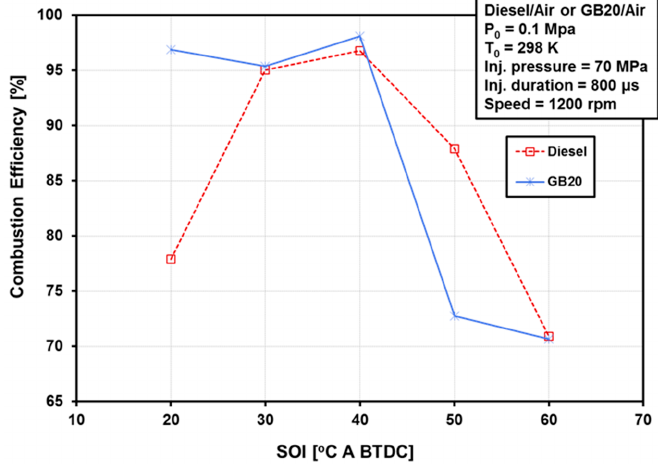
Figure 10. Combustion efficiency [Reprinted from Fuel, Vol. 189, Yanuandri Putrasari, Ocktaeck Lim, A study on combustion and emission of GCI engines fueled with gasoline-biodiesel blends, Copyright (2017); with permission from Elsevier].